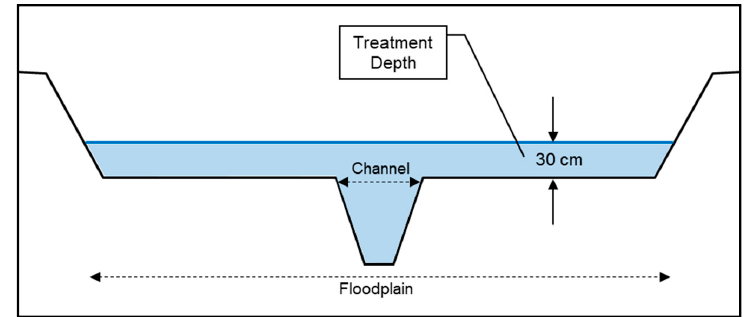
Figure 3. Conceptualized floodplain treatment volume with 30 cm of flow depth.